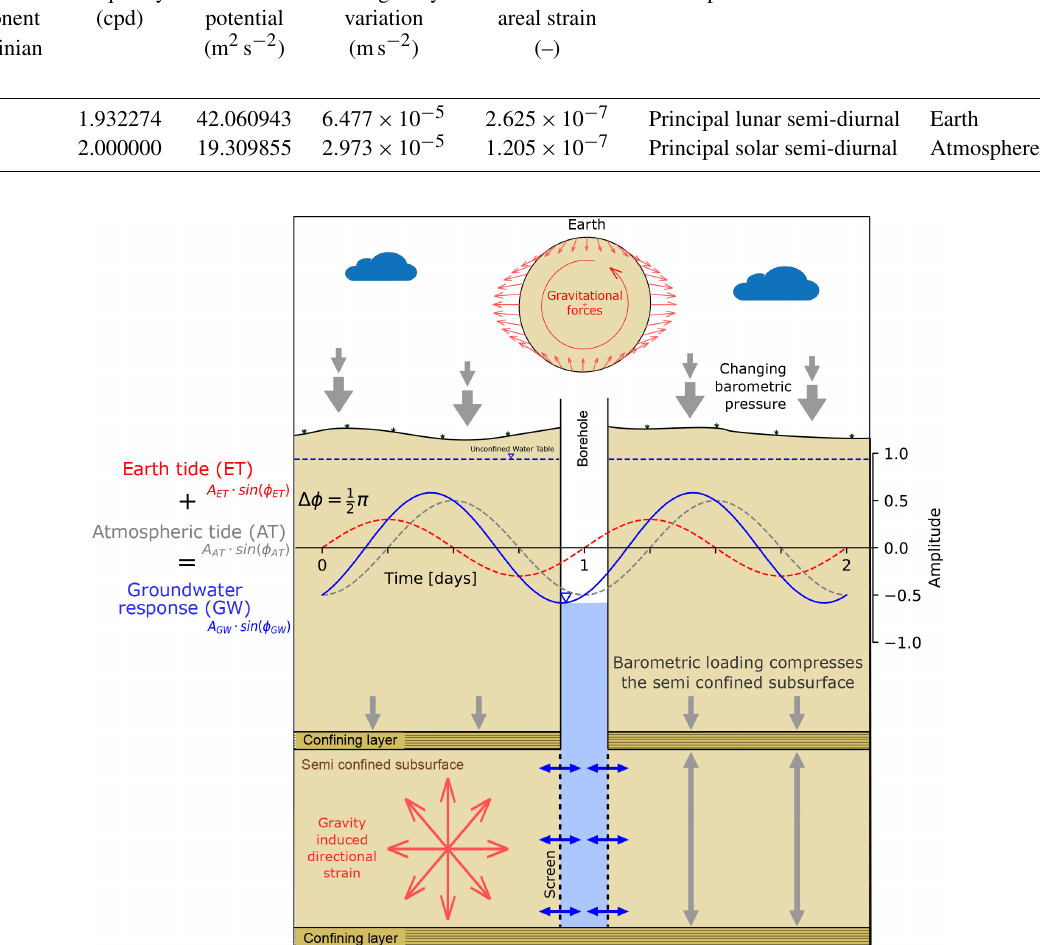
Figure 1. Representation of the groundwater level measured as pressure head in a well penetrating a confined aquifer with a rigid matrix subjected to ET (red) and AT (grey), adapted from McMillan et al. (2019). The result of these two effects can be expressed as a function of harmonic addition within the measured groundwater levels. The gravity-induced directional strain and vertical barometric loading combine to force water into and out of the